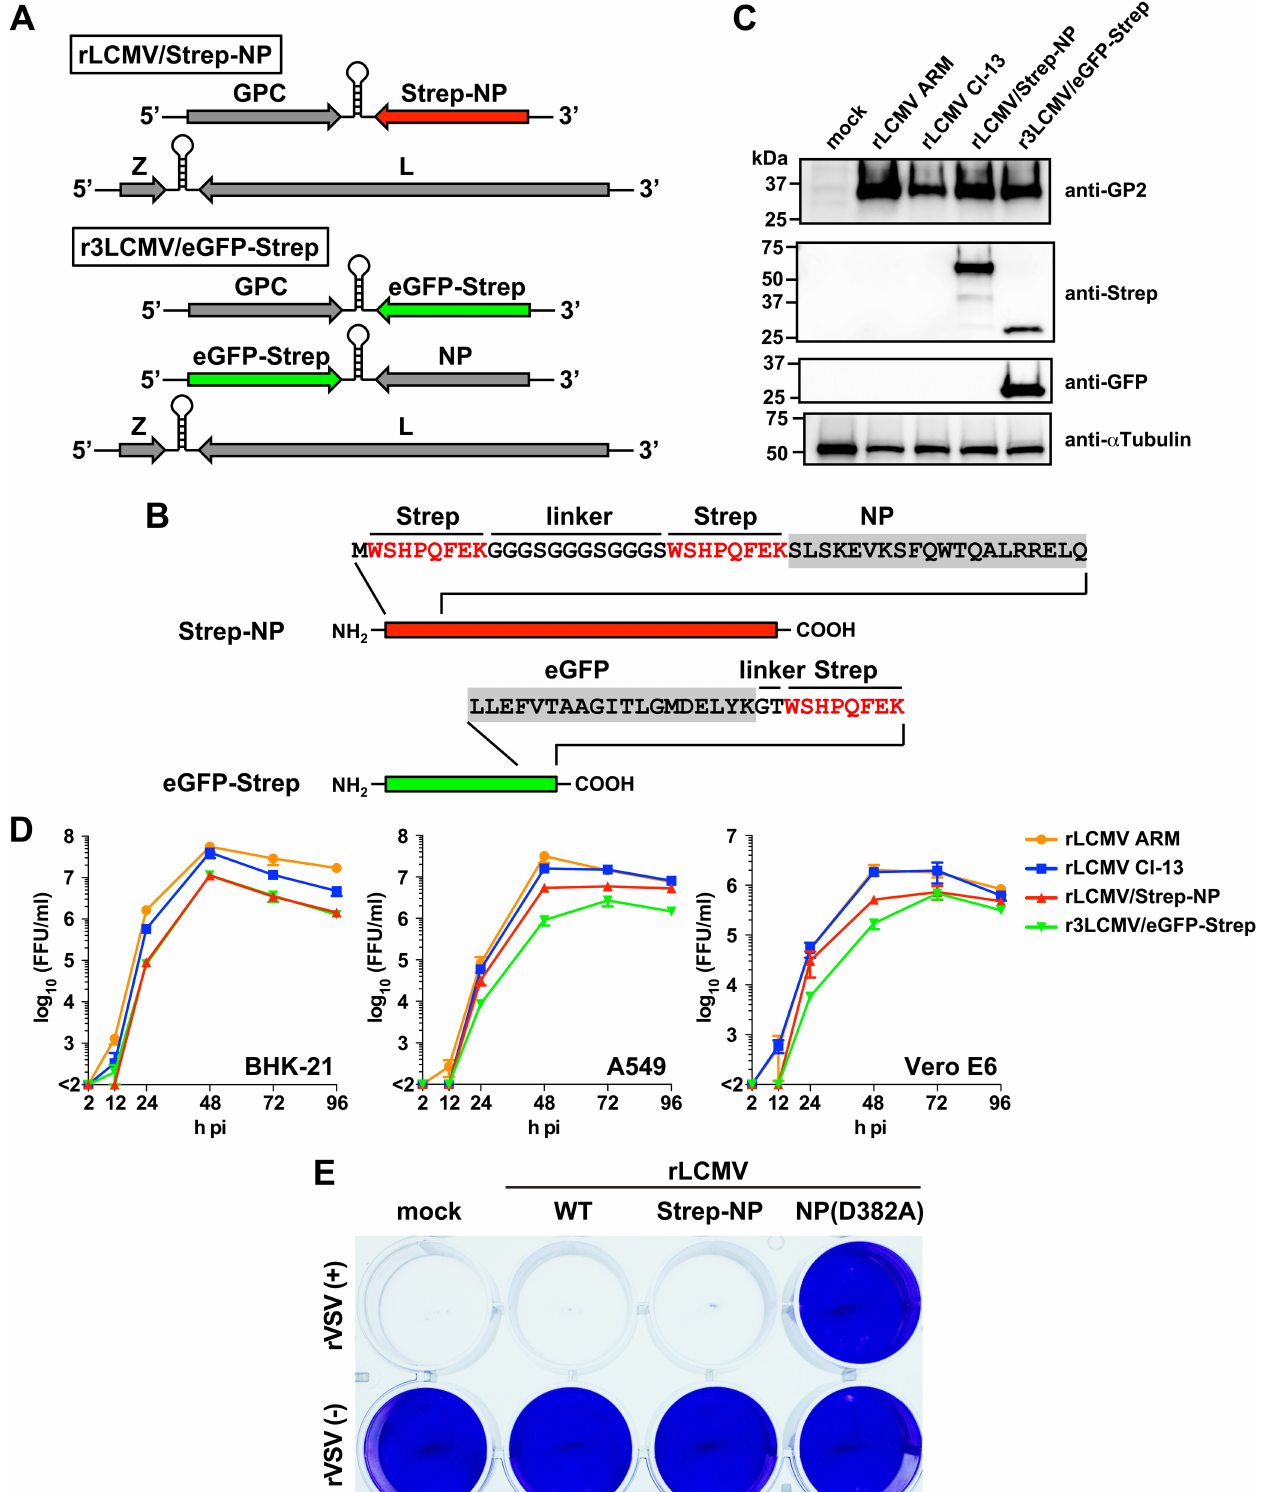
Fig 1. Generation and characterization of rLCMV/Strep-NP and r3LCMV/eGFP-Strep. (A, B) Schematic of the genome organization of rLCMVs expressing Strep-NP or eGFP-Strep (A) and amino acid composition of N- and C-terminus regions of Strep-NP and eGFP-strep, respectively (B) .